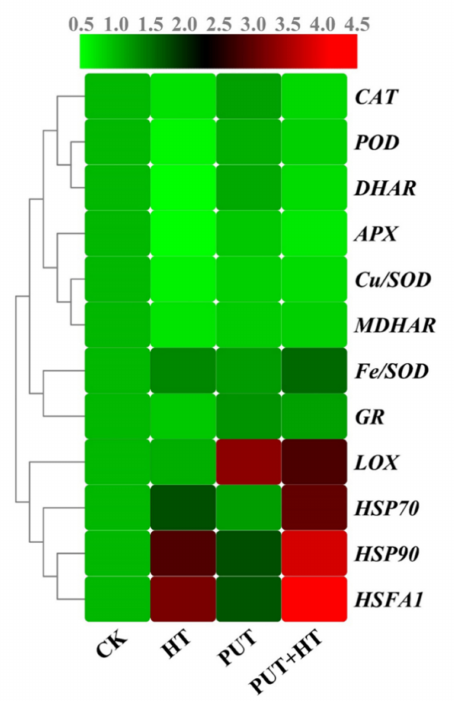
Figure 9. Heat map showing the expression of different stress-related genes in tomato leaves exposed to high temperature in the presence or absence of putrescine treatment. The intensity of gene expression ranges from deep green (low) color to deep red color (high). CK: control; Put: 1 mM putrescine; HT: heat stress (38/28 ◦ C); Put + HT: 1 mM putrescine and heat stress. Antioxidant-related genes ( FeSOD, MnSOD, CAT, POD, APX, GR, MDHAR, DHAR, GST, LOX ); and Heat shock-related genes ( HSP90, HSP70, HSfA1